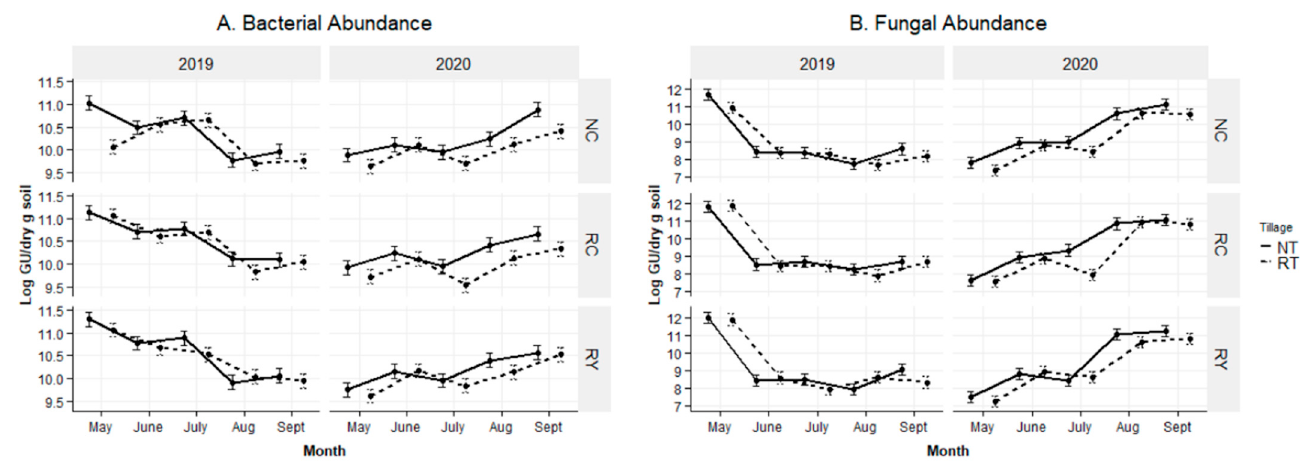
Figure 6. Bacterial and Fungal Abundance. Model predicted values of Bacterial ( A ) and Fungal ( B ) abundances in each treatment combination within each combination of treatments (NT = no-till, RT = reduced till, NC = no cover, RC = rye + clover cover crop, RY = rye cover crop) over time (May–September 2019 and 2020) reported in [45]. Error bars depict standard error of predicted values. Treatment plots were located in Stoneville, MS, USA.